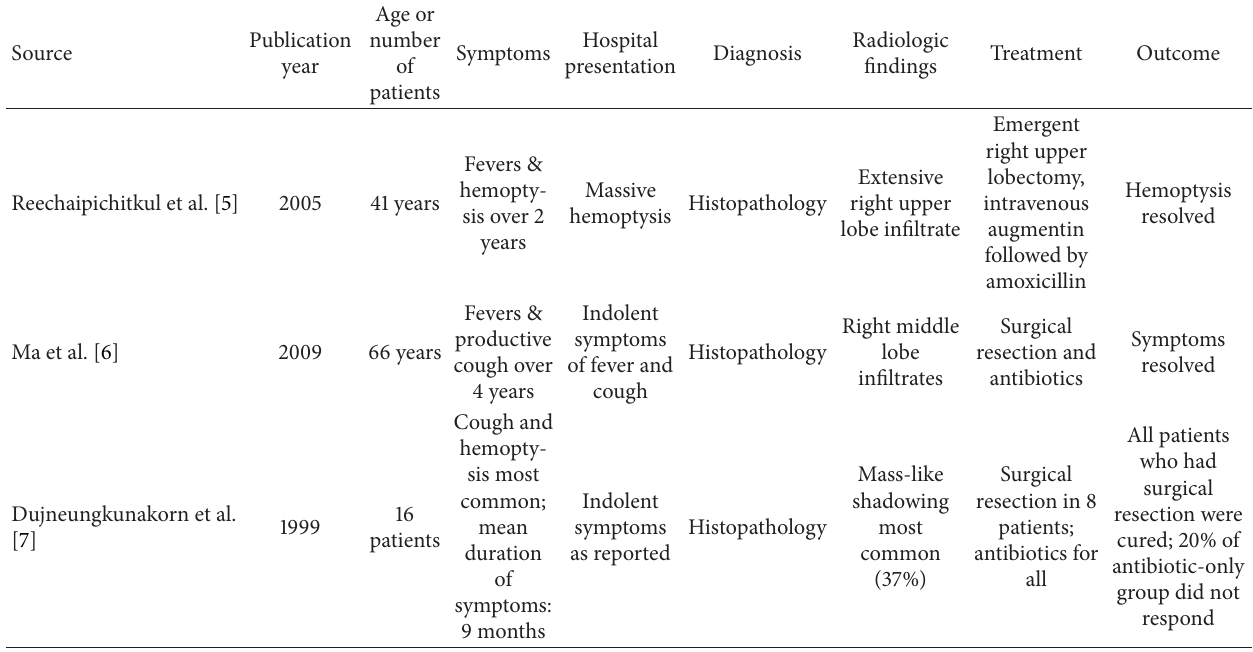
Table 1: Indolent cases of